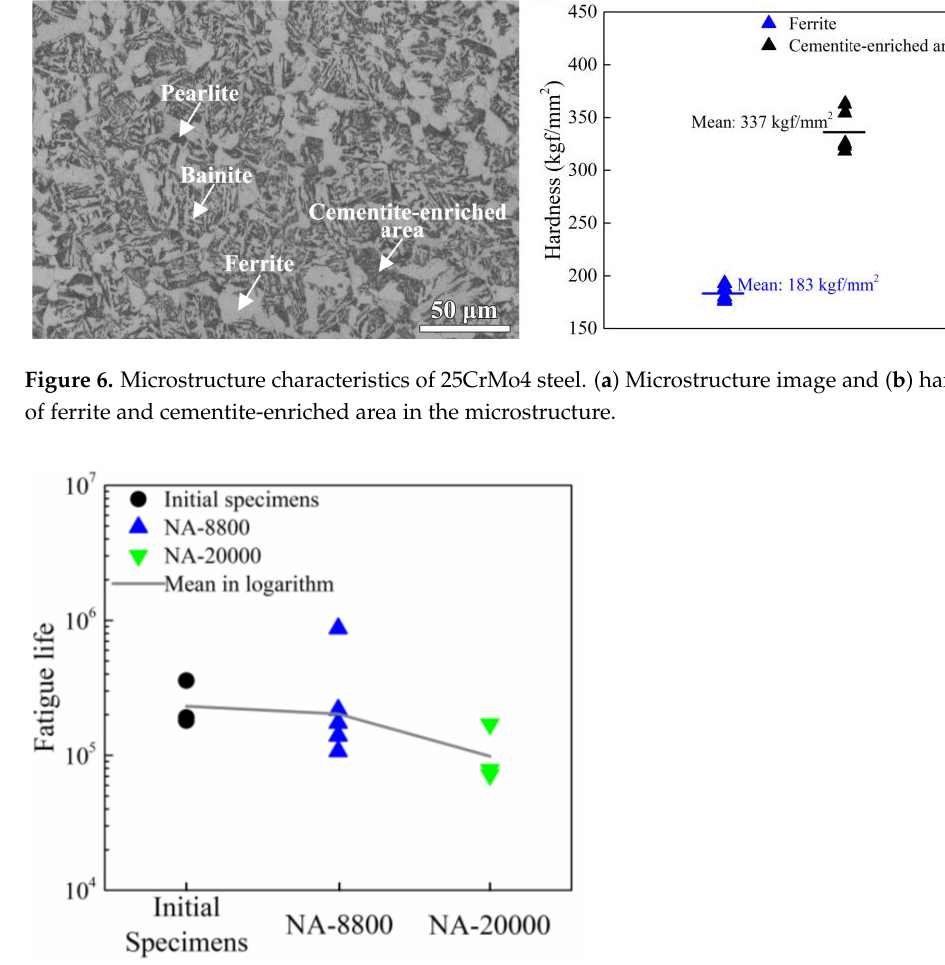
Figure 7. Fatigue life of 30CrMnSiA specimens versus natural-aging